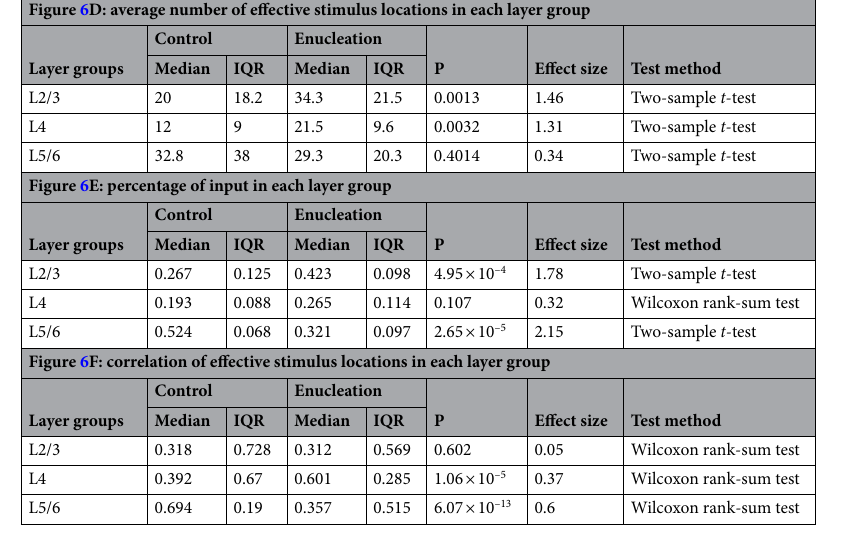
Table 6. Statistics in Fig. 6. IQR interquartile range.